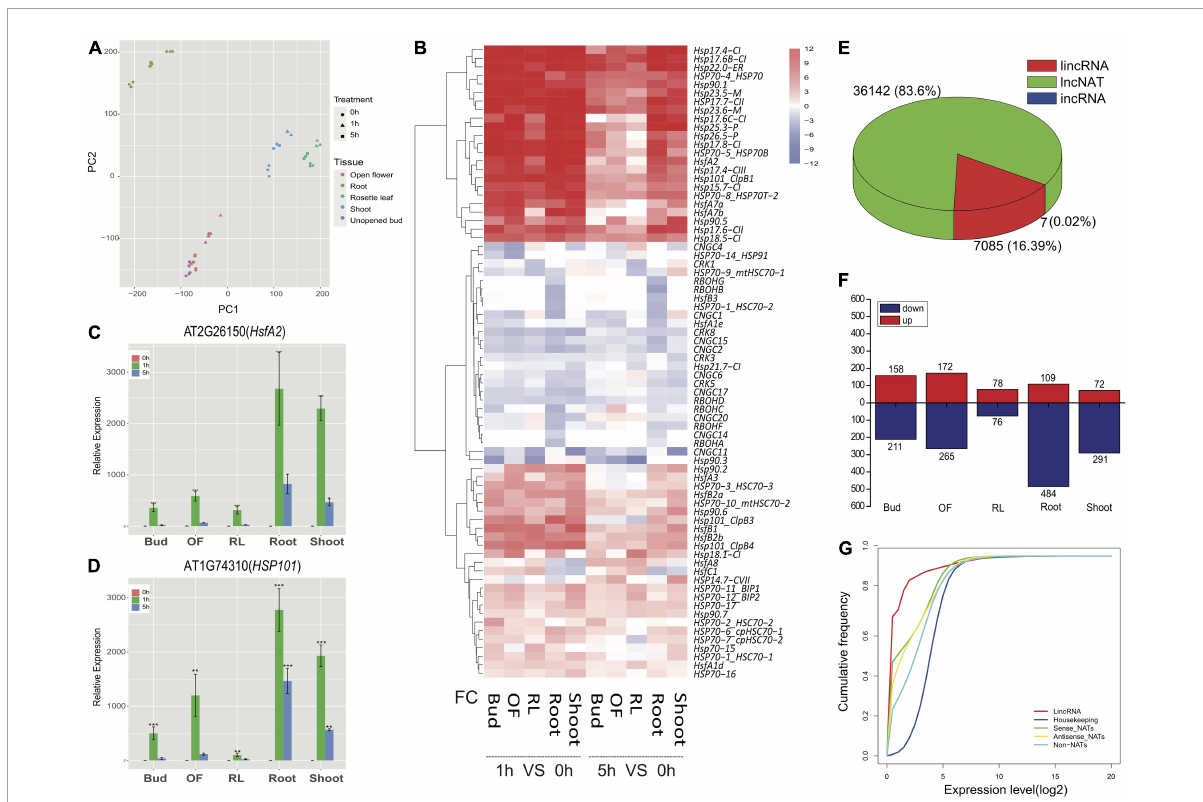
FIGURE1 Transcriptomic responses in different tissues and long non-coding RNA expression under heat treatment. (A) PCA of transcripts derived from vegetative and reproductive tissues. (B) Heatmap for transcripts of identified heat responsive genes. X axis represents the log2 fold change (FC) of transcript abundance between control samples and heat-treated samples. (C) qRT-PCR for transcripts of heat response marker gene HSFA2. (D) qRT-PCR for transcripts of heat response marker gene HSP101. (E) The number of long non-coding RNAs identified under heat treatment. (F) The number of differentially expressed lincRNAs in different tissues. (G) Cumulative frequency for expressions of lincRNAs, housekeeping genes, sense genes of NATs, antisense gene of NATs and non-NAT genes. * P < 0.05, ** P < 0.01, *** P < 0.001 in Dunnett’s two-sided test against 0 h. Error bars indicate SD ( n =